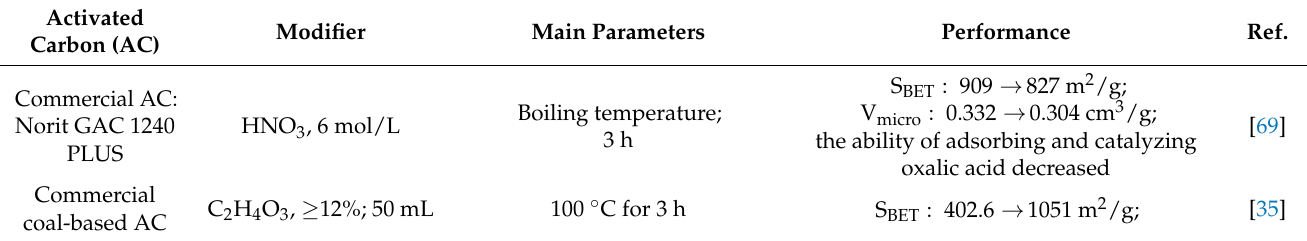
Table 2. Effect of modification on the properties of activated